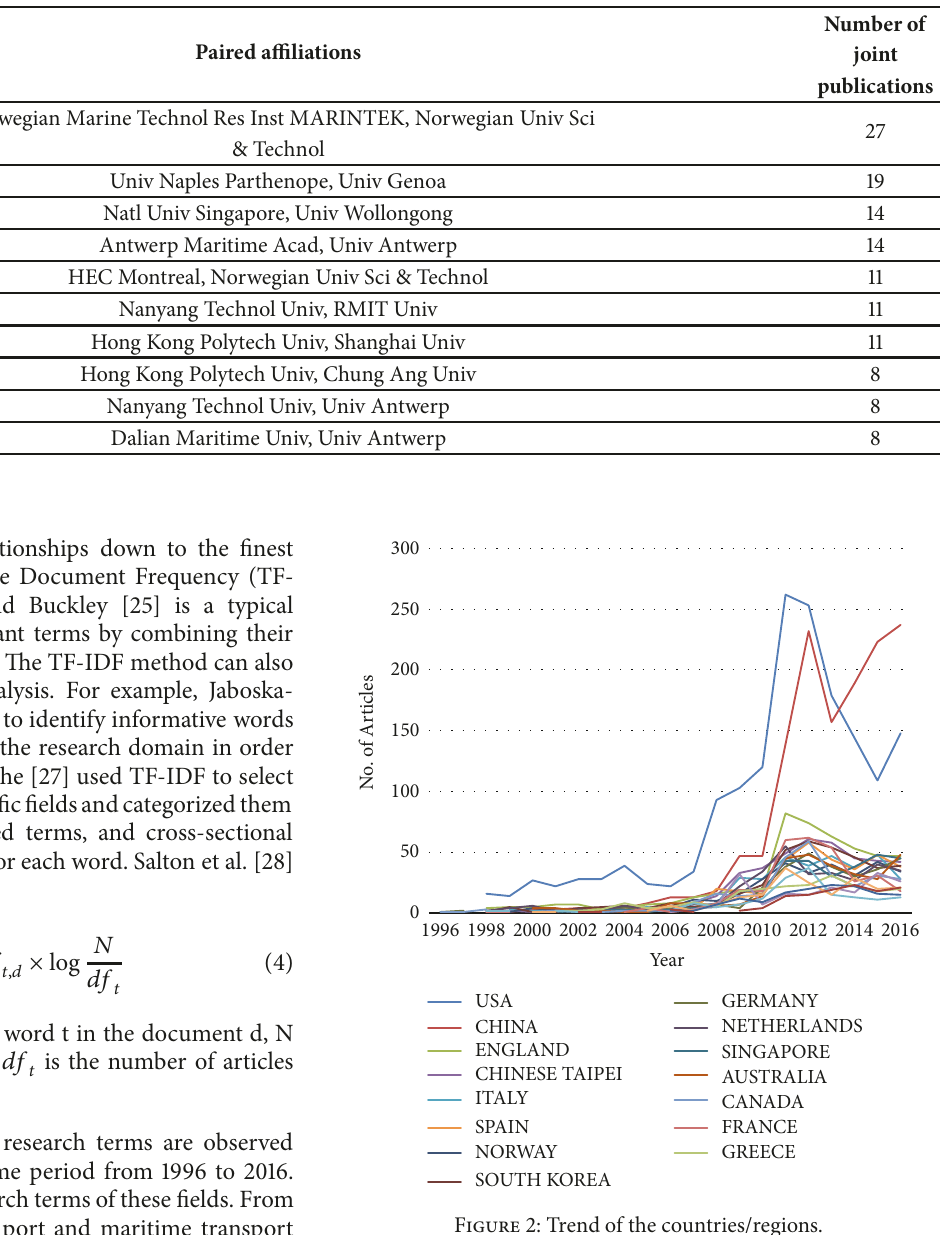
Table 8: The most prolific paired affiliations.